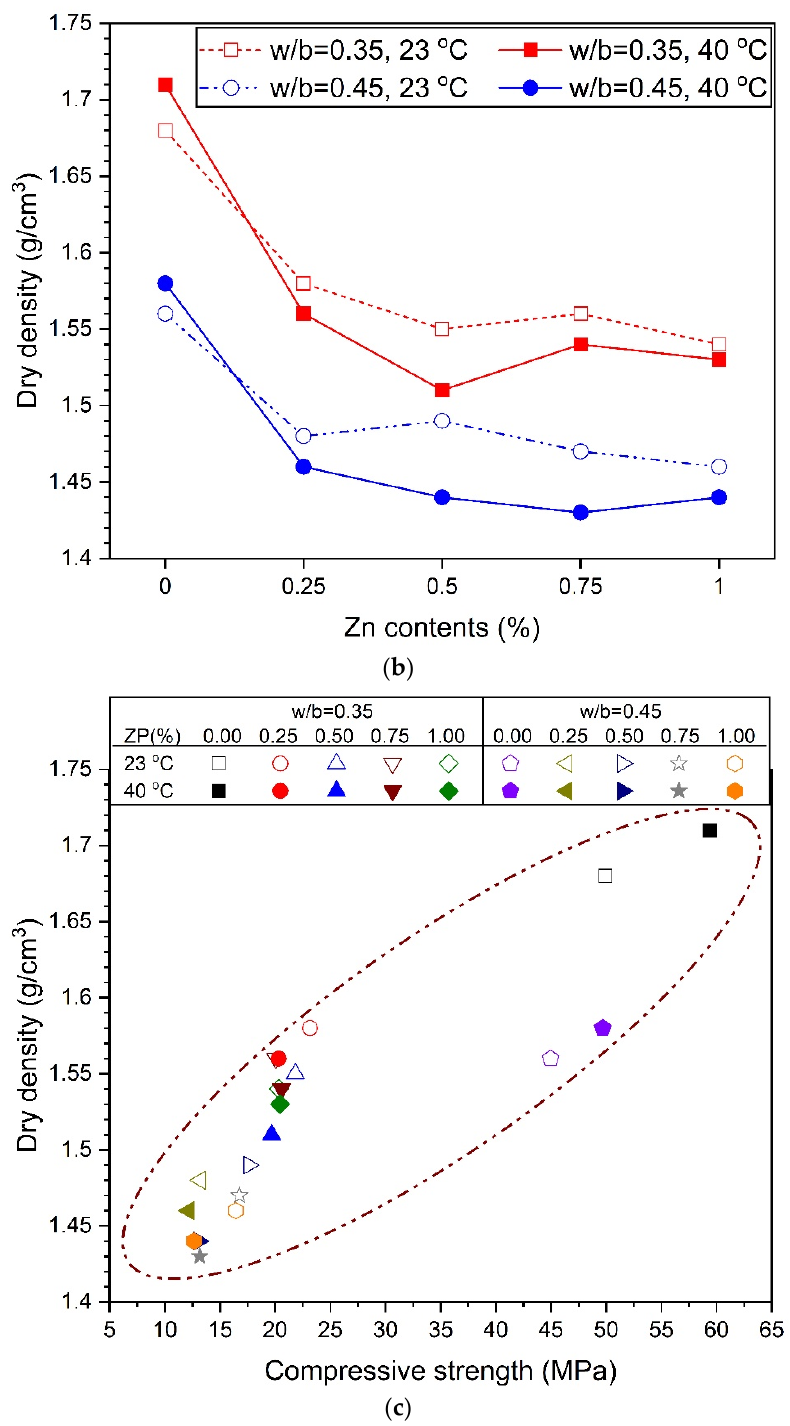
Figure 7. Water absorption and UPV variation with Zn content—( a ) water absorption, ( b ) dry density, and ( c ) dry density vs. compressive strength.